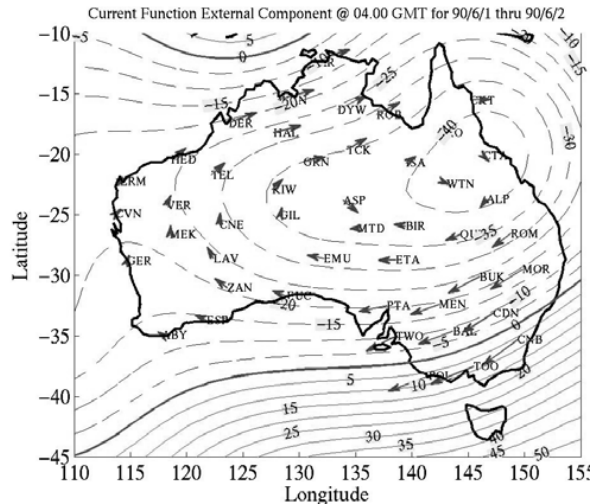
Fig 3. Current systems at 4 h UT on 2 June 1990. The arrows are drawn by rotating the observed Fig. 3. Current systems at 4h UT on 2 June 1990. The arrows are drawn by rotating the observed magnetic field directions clockwise magnetic field directions clockwise through 90°. The contours have a spacing of 5 kA and are derived through 90 ◦ . The contours have a spacing of 5kA and are derived by spherical cap harmonic analysis. by spherical cap harmonic analysis.